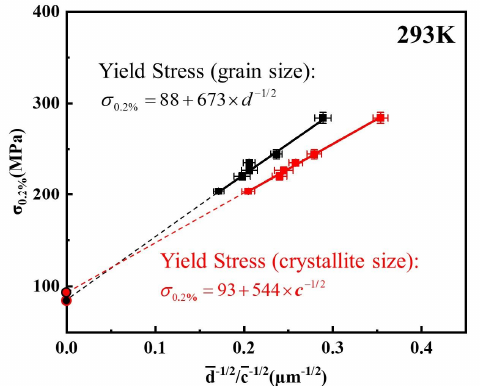
Figure 7. Yield stress (σ 0.2% ) at 293 K versus the reciprocal of the square root of the grain size ( d ) and crystallite size ( c ). The obtained Hall-Petch relationship is indicated within the plot. Table 3. Hall-Petch parameters of Ni 2 CrFe MEA and comparison with FCC type alloys from the